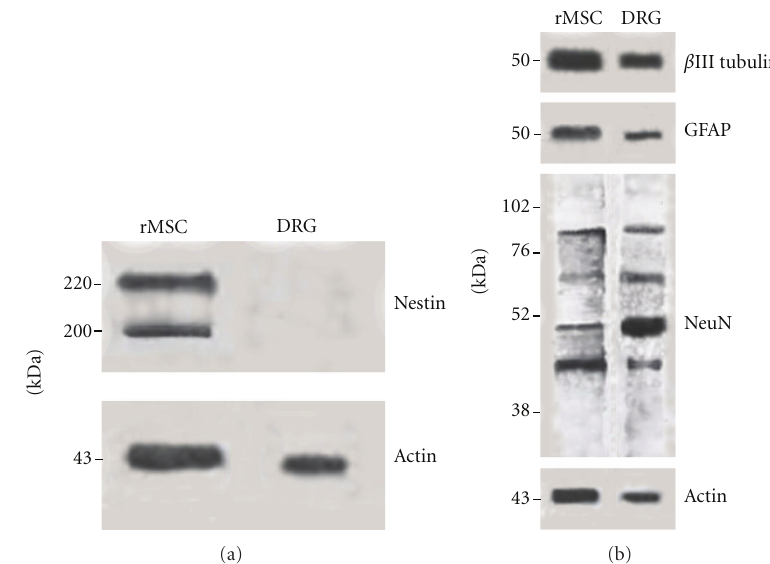
Figure 7: rMSC expression of neural markers by immunoblotting. Protein extracts (15 μ g), from rMSC or DRG cultures, were separated by 7.5% SDS-PAGE (a) or 13% SDS-PAGE (b) and transferred to a nitrocellulose membrane. Membranes were, respectively, blotted with anti-nestin, anti- β III-tubulin, anti-GFAP, and anti-NeuN antibodies. Two bands corresponding to 200 and 220 kDa molecular weight were evident for nestin (a), a 50 kDa band for β III tubulin and GFAP (b) immunoblottings. The NeuN blot shows two major bands at 45–50 kDa and additional reactive bands at ∼ 66 kDa and between 70 and 90 kDa (b). Actin was used as loading control (a and